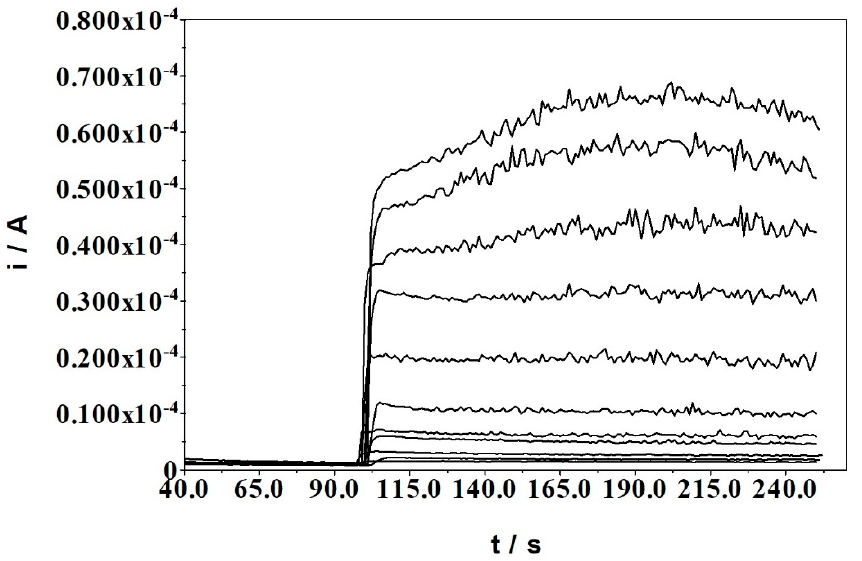
Figure 6. Amperometric response for increasing cholesterol concentrations (0.025, 0.05, 0.1, 0.2, 0.35, 0.5, 1, 2, 3, 5, 7 mM) added in the background mixture (chloroform-TBAP + 1 mL acetic anhydride + 100 µ L H 2 SO 4 ), applying 1.5 V potential.